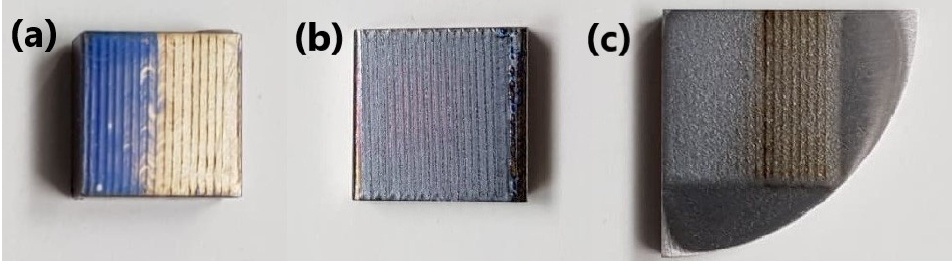
Figure 2. The samples after laser treatment: ( a ) grade IV titanium (LT1), ( b ) Ti-6Al-4V alloy (LT2) and ( c ) Ti-13Nb-13Zr alloy (LT3). Sample LT1 was characterized by the presence of two areas with different colors: blue and yellow. The LT2 sample also had local color changes. The last sample, LT3, was darker (brown) and lighter (white). The different colors of the presented samples resulted from the various thicknesses of the oxide layers formed after laser